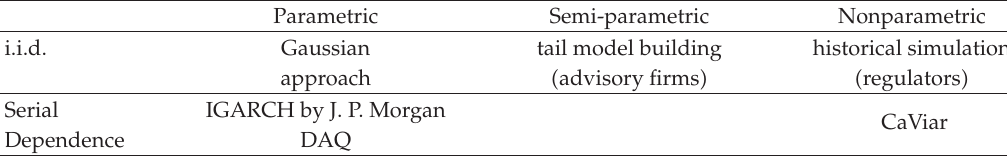
Table 1: Computation of the